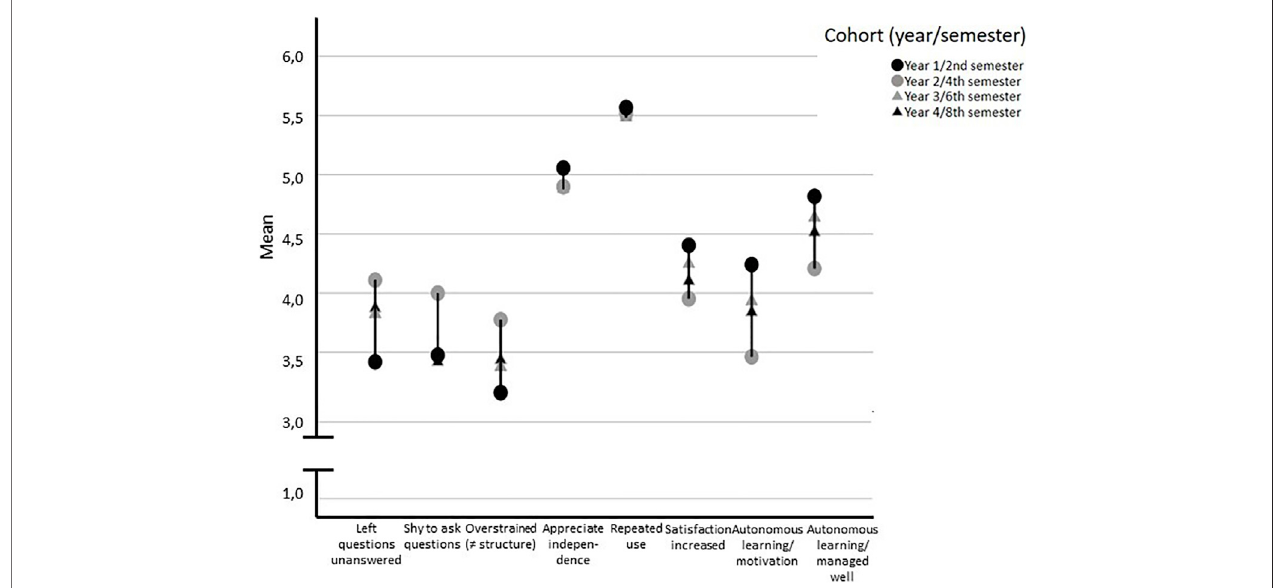
FIGURE 1 | Drop-line chart showing the difference of positive and negative perceptions of digital teaching between four cohorts.